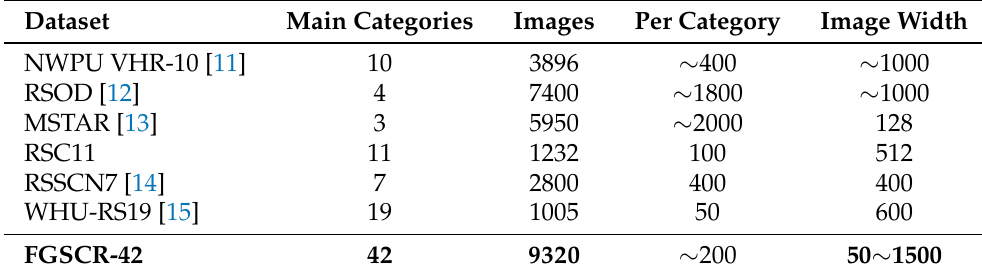
Table 2. Comparison among FGSCR-42 and some other remote sensing image datasets for